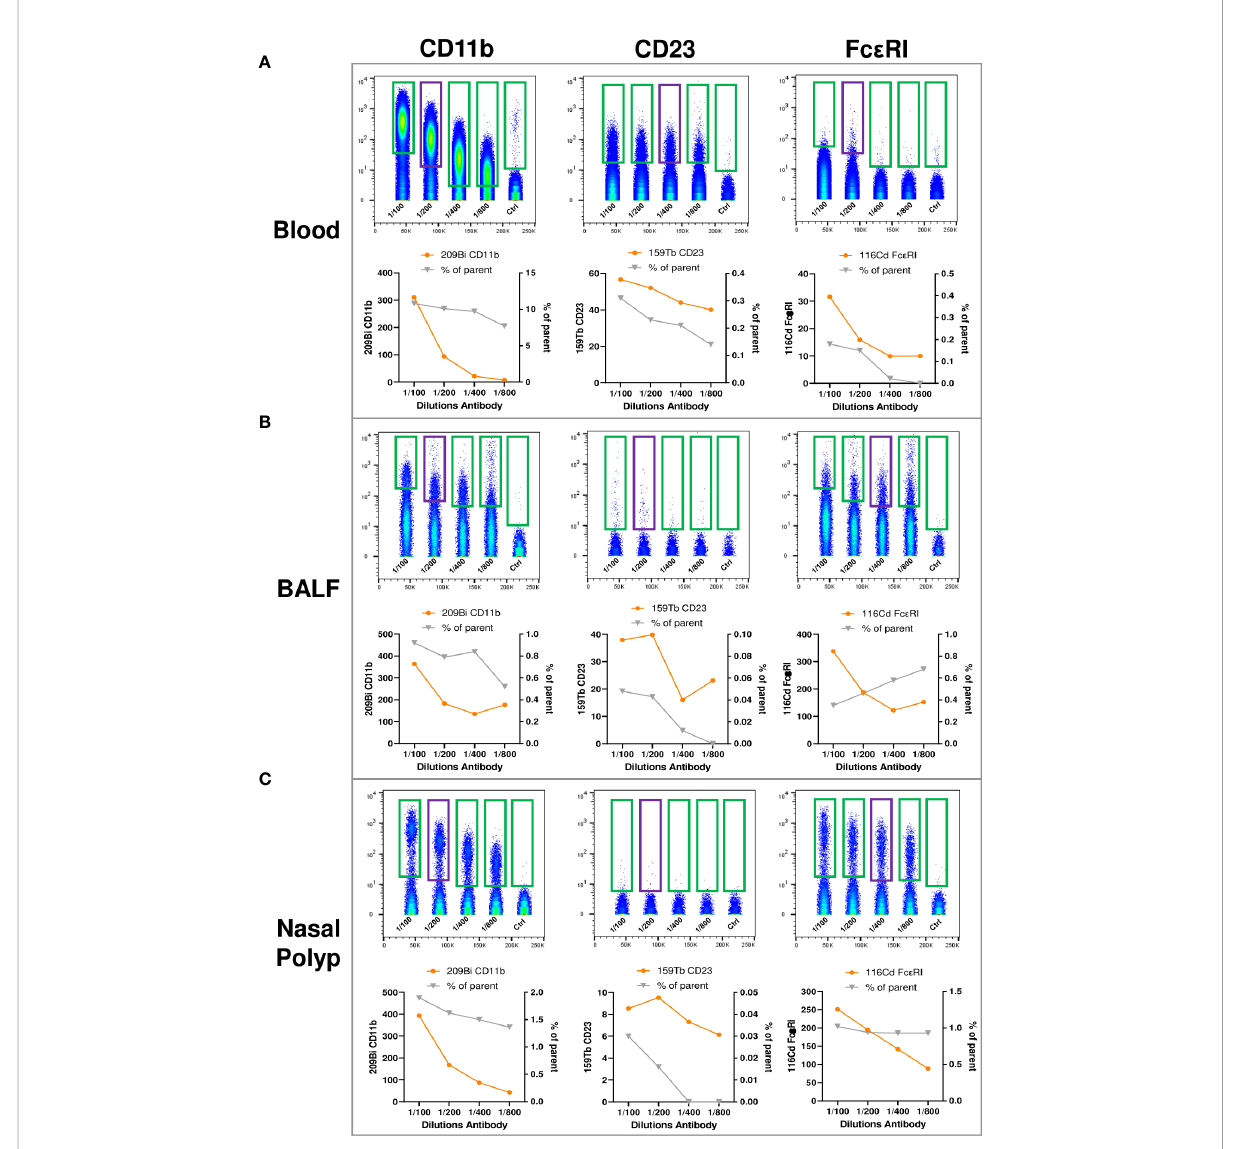
FIGURE 3 Titration of anti-human CD11b, anti-human CD23, and anti-human Fc ϵ RI antibodies for expansion of the MDIPA panel. (A-C) , (A) Blood, (B) bronchoalveolar lavage fl uid (BALF) and (C) nasal polyp were stained with serial dilutions (1:100, 1:200, 1:400, 1:800 and unstained control) of 209 Bi anti-human CD11b (left panels), 159 Tb anti-human CD23 (middle panel) and 116 Cd anti-human Fc ϵ RI (right panels). Lower panels show mean metal intensity (left y-axis) and percentage of cells positive for the respective antibody (right